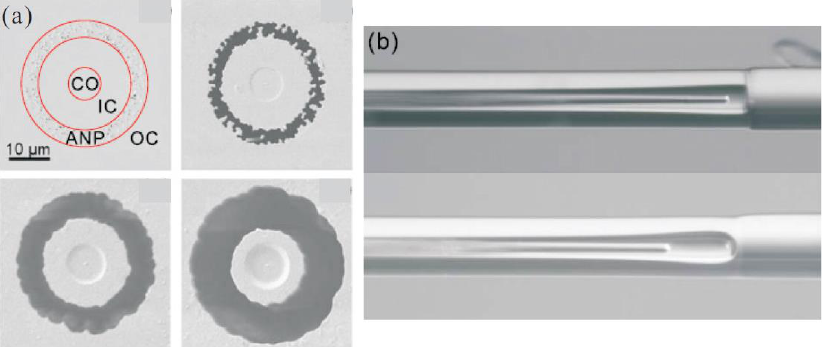
Figure 13. ( a ) SEM images of the transversal cross-section of the bend-insensitive fiber (BIF) after different etching time; ( b ) Optical microscope images of the in-line fiber cantilevers [206].